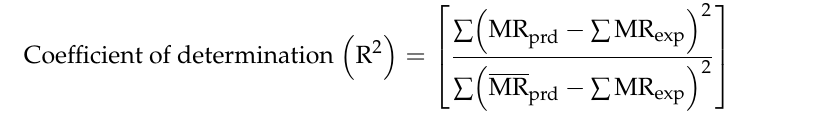
Table 1. Empirical models used to describe the drying kinetics of Kyoho skin 1 .